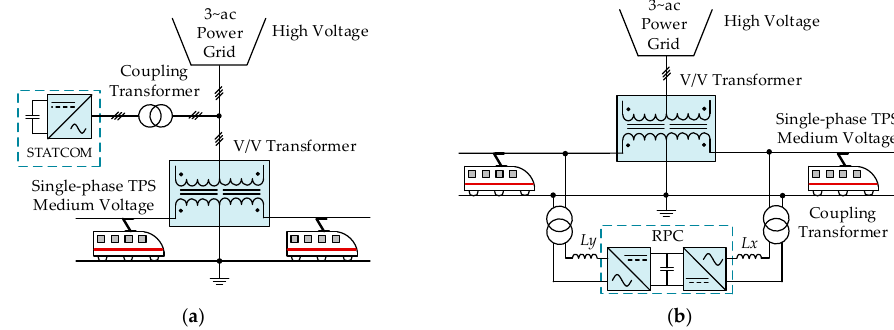
Figure 28. Power electronics compensators in ac railway electrification: ( a ) static synchronous compensator (STATCOM); ( b ) rail power conditioner (RPC).